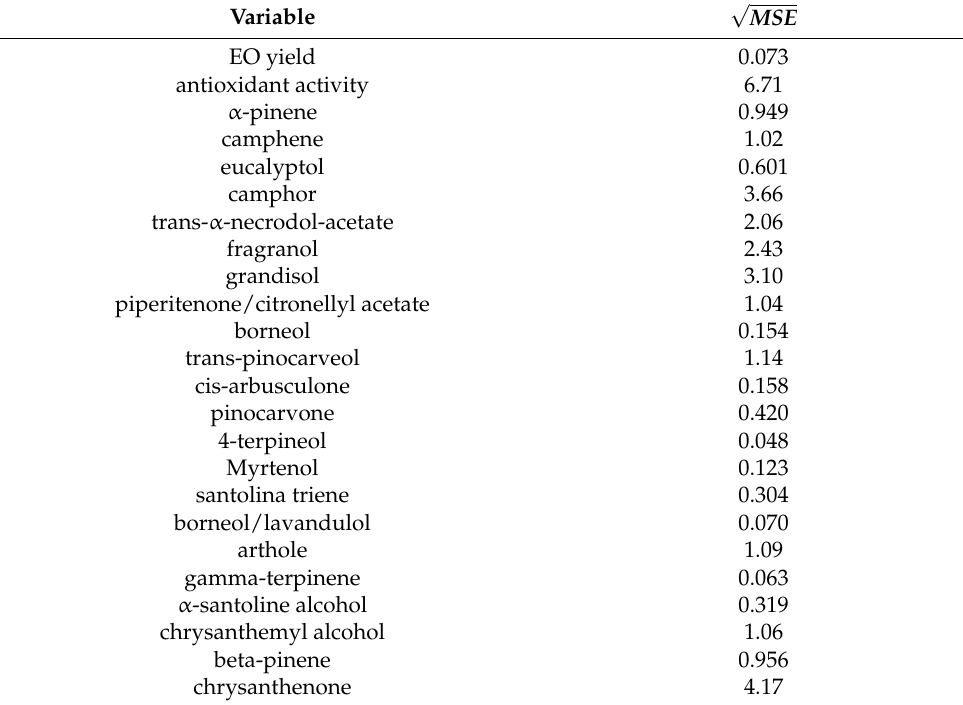
Table 3. Square root of mean squares error (MSE) that estimates the common standard deviation ( σ ).